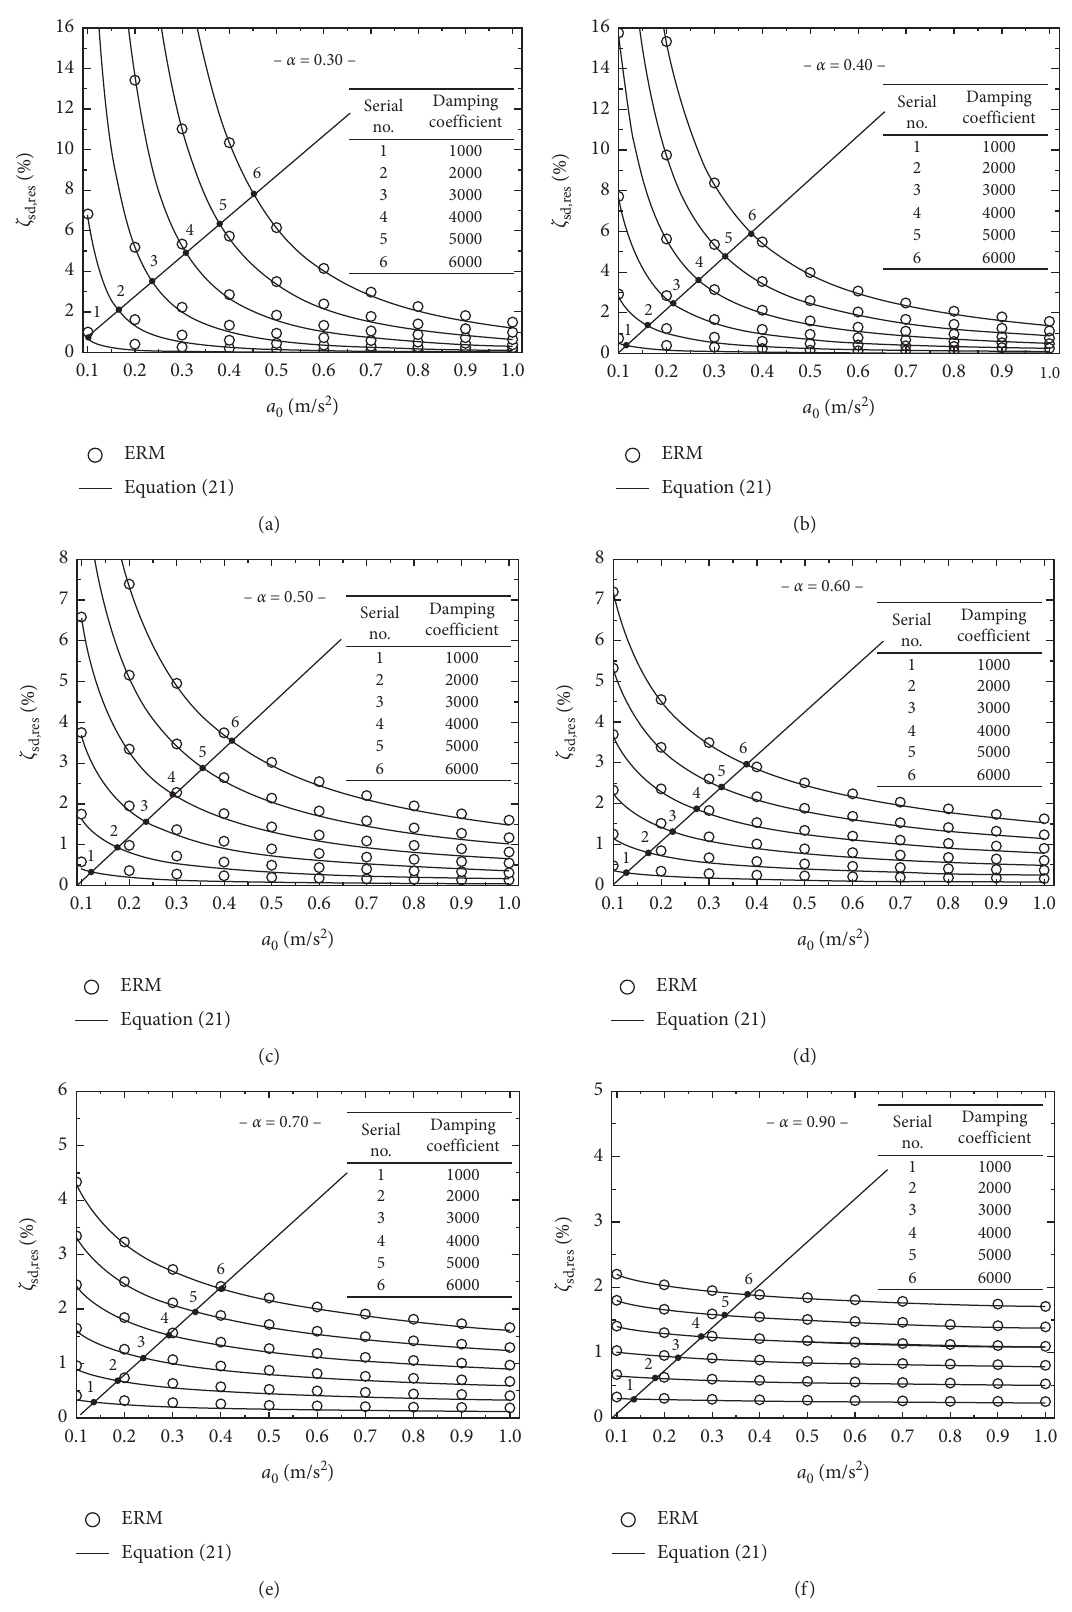
Figure 5: ADRs calculated using the two methods for c α � 0.50; (d) α � 0.60; (e) α � 0.70; (f) α �